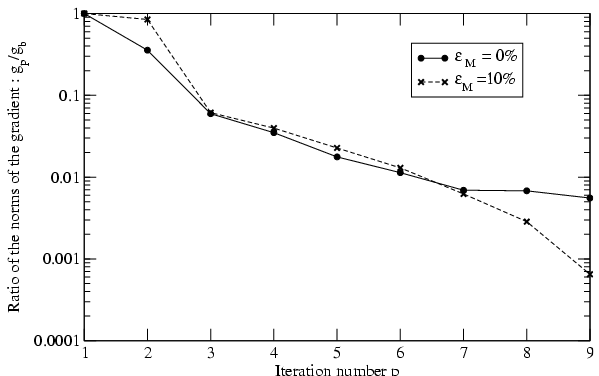
Fig. 6. Differences (ppb) between NO surface concentrations ob- tained with the true emission inventory and with the first-guess in- ventory +100% at 9 a.m.